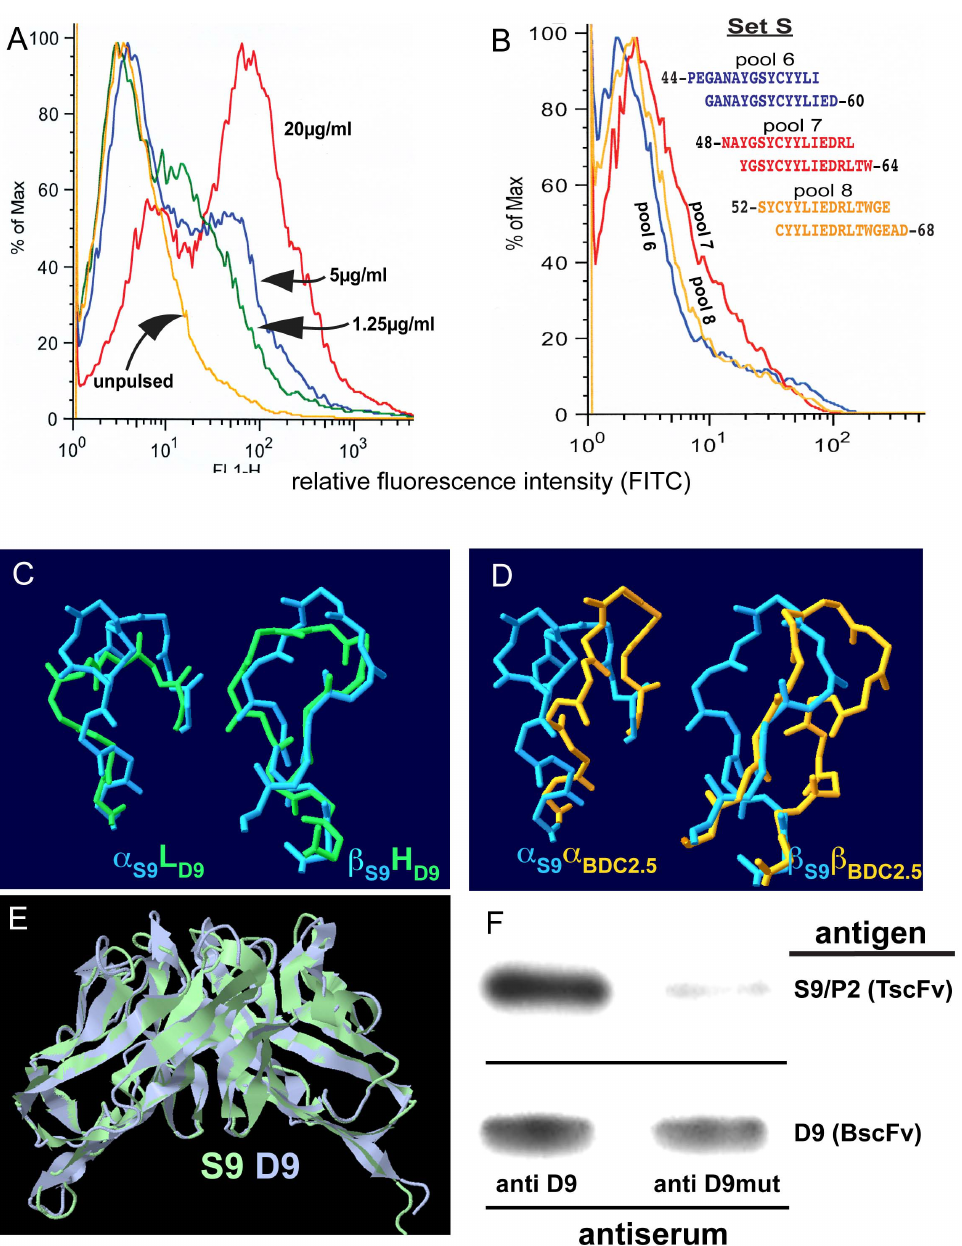
Figure 5. TscFv S9/P2, an idiotype structurally similar to that of BscFv D9. Given that D9 (a BscFv) is an idiotype with known specificity the aim was to isolate another idiotype structurally similar to D9, but different in its primary sequence. To achieve this aim a TscFv library was generated and selected by applying two different selection methods: 1) precipitation of the TscFv library with anti D9 antiserum that had been adsorbed with D9mut to reduce the presence of antibodies recognizing linear epitopes and 2) selection of the TscFv library on NtfrRII-pulsed NOD APCs. The criterion to screen the two resulting selected libraries P and S (same clone isolated by both selection methods) was chosen to yield an idiotype that recognized the same pMHC complex as D9. Spleen cells of NOD mice were pulsed with NtfrRII and stained with TscFv S9/P2 (A) or pulsed with NtfrRII peptide pools of set S (B). As with D9, spleen cells pulsed with peptide pools outside the region 44–68 of RegII did not stain with S9/P2. Given that BscFv D9 and TscFv S9/P2 represent two idiotypes with different primary sequences, but recognizing the same pMHC complex, we assessed their structural relatedness. A direct comparison of the CDR3 loops of D9 (green) with S9/P2 (blue) revealed structural overlap despite significant differences on the primary sequence level (Table S10 in File S4). The structural overlap was most notable for the b -chain of TscFv S9/P2 and the heavy chain of BscFv D9 (C). In contrast, a comparison of the CDR3 loops of TscFv S9/P2 (blue) and TscFv BDC2.5 (orange), which recognize different epitopes in the context of I-A g7 , showed marked differences (D). The structural homology between BscFv D9 and TscFv S9/P2 extended beyond the CDR3 regions to encompass the entire molecule (idiotype) as shown in (E) and as evidenced by the template modeling (TM) scores for this alignment, which are provided in Table 1. In keeping with this observation, anti D9 serum was able to precipitate both BscFv D9 and TscFv S9/P2, anti D9mut serum precipitated D9, but only marginally TscFv S9/P2 (F). Lysates of bacteria expressing D9 or S9/P2 were precipitated with sera from anti D9 or anti D9mut-immunized mice. Precipitates were captured by immobilized protein A/G, were run in adjacent lanes of an SDS-PAGE gel and blotted to nitrocellulose. Bands were detected with an anti c-myc, HRP-labeled antibody. The bands corresponding to the scFvs run at an apparent molecular weight of , 29 kD. The experiment was repeated once yielding the same result.